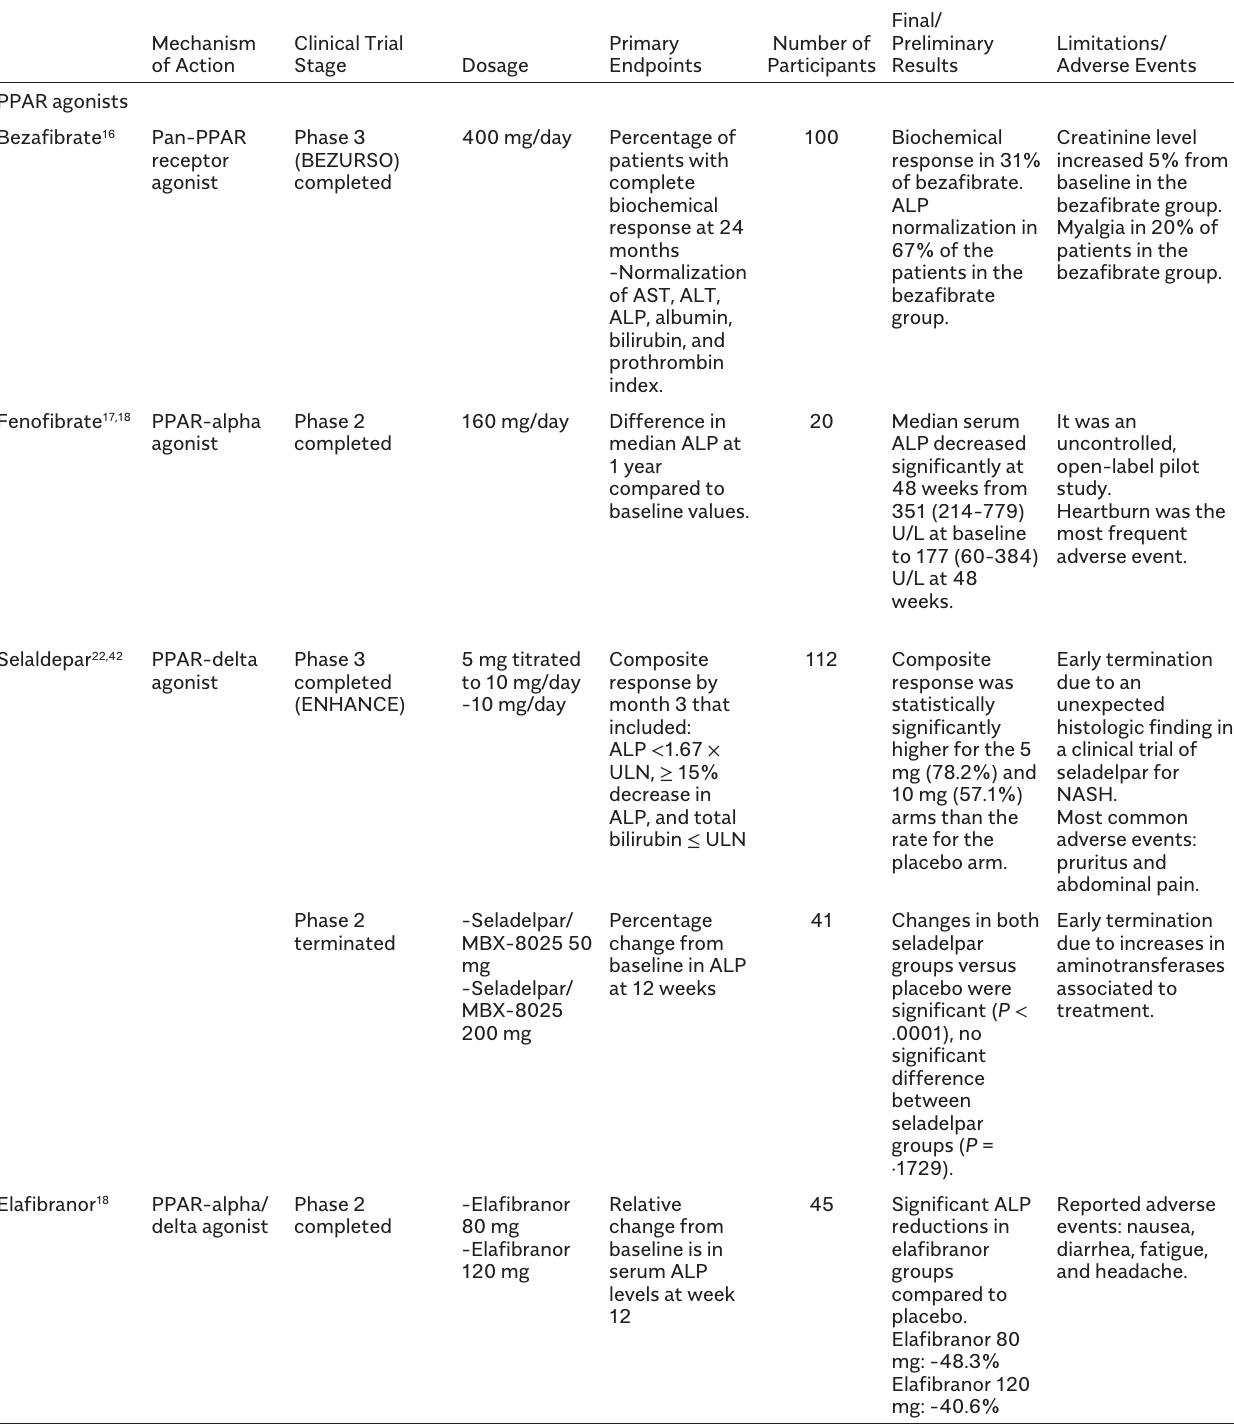
Table 2. Investigational Therapeutics for the Treatment of Primary Biliary